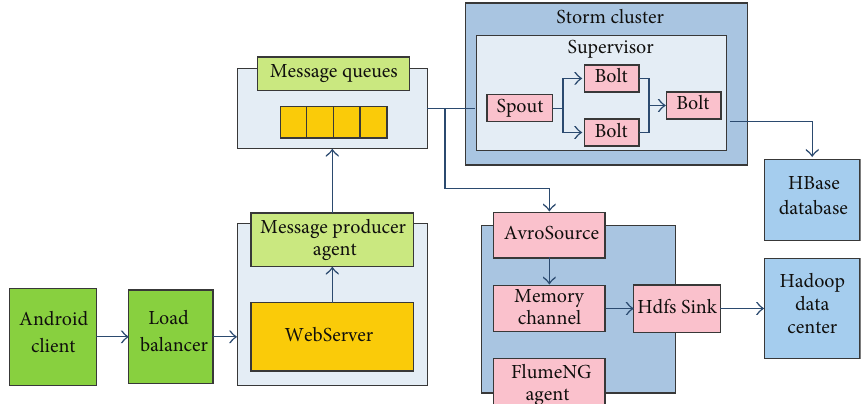
Figure 6: The distributed data processing subsystem of the X73 uHealth system.